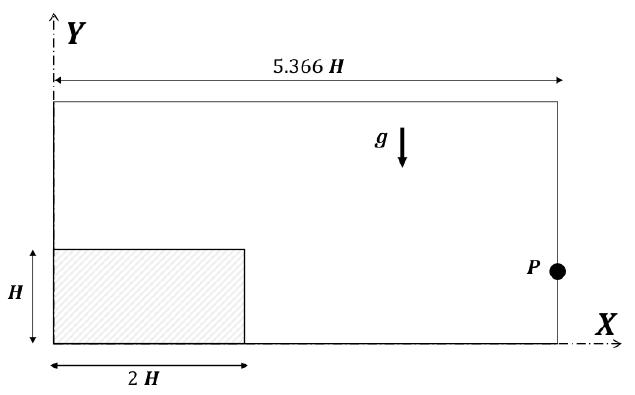
Figure 12. Two-dimensional dam-break flow: problem